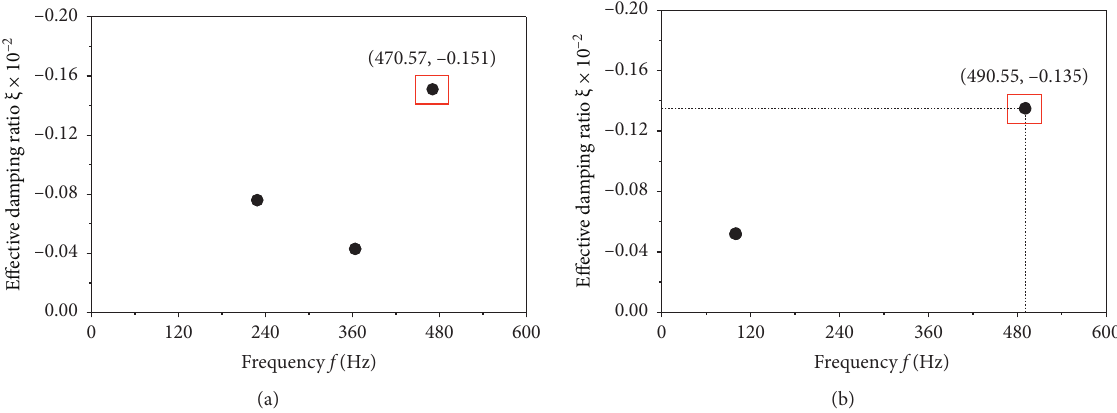
Figure 5: Frequency distributions of frictional self-excited vibration of the wheelset-track system: (a) the power wheelset, (b) the trailer